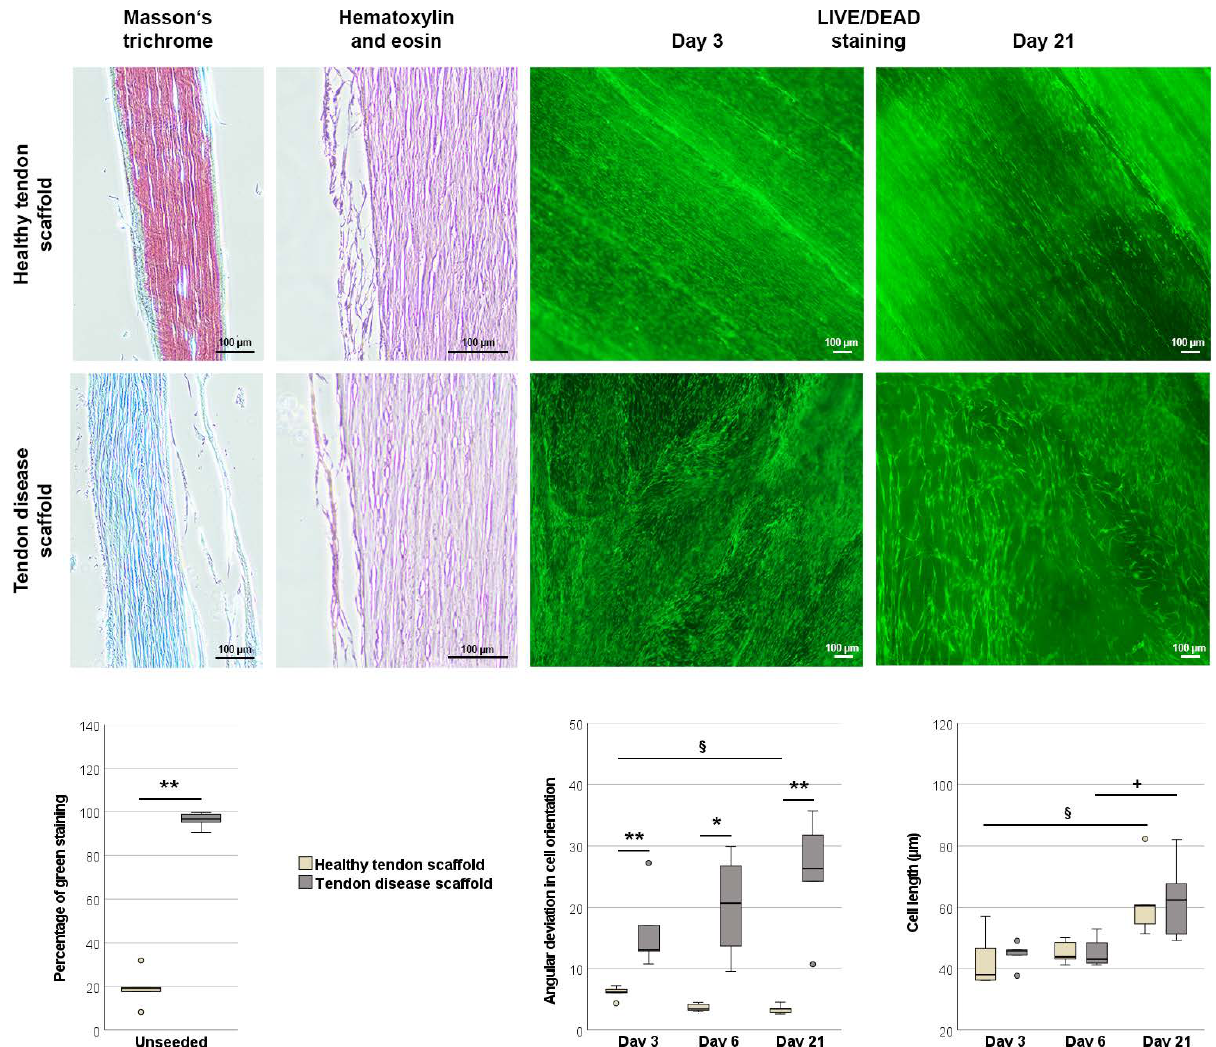
Figure 4. Morphological analysis of unseeded and MSC-seeded healthy and diseased tendon scaffolds. Masson’s trichrome staining was performed to confirm tendon disease using unseeded scaffolds. Healthy scaffolds stained mainly red, representing healthy tendon fibers, while tendon disease scaffolds stained mainly green, representing altered tendon tissue. The boxplot displays the percentage of green staining. Hematoxylin and eosin staining of seeded tendon scaffolds showed that cell layers were mostly found on the scaffold surface, with no major differences between the scaffold groups. Live/Dead staining (live cells shown in green) of tendon scaffold cultures revealed a more random orientation of MSCs on the disease scaffolds, as quantified by the mean angular deviation from the median angle in cell orientation shown in the boxplot. It also showed that MSC length increased over time, which was also quantitatively confirmed as shown in the boxplot. All scale bars: 100 µ m. Asterisks indicate significant differences between groups with p < 0.05 (*) or p < 0.01 (**). Significant differences over time are indicated by paragraph symbols for healthy tendon scaffold cultures and by plus symbols for diseased tendon scaffold cultures ( p < 0.05). Data were obtained using scaffolds from n = 5 different tendons per